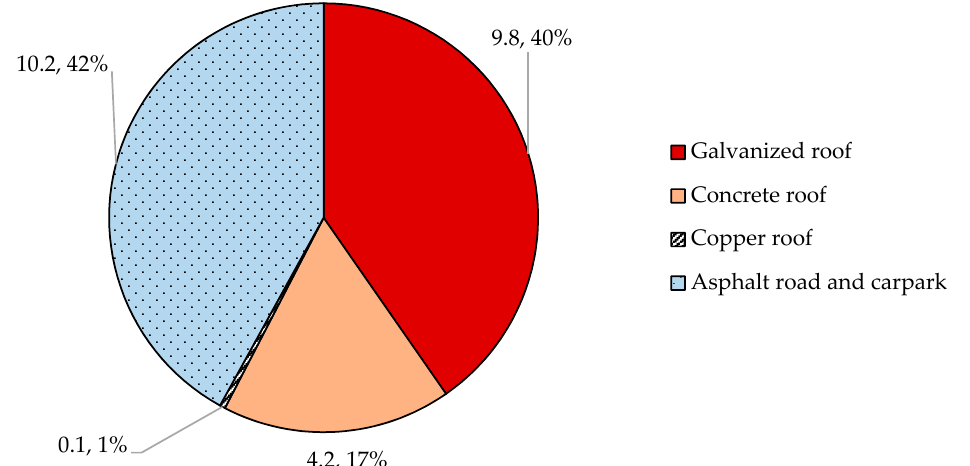
Figure 3. Relative impermeable area (ha) and percentage of surface type.